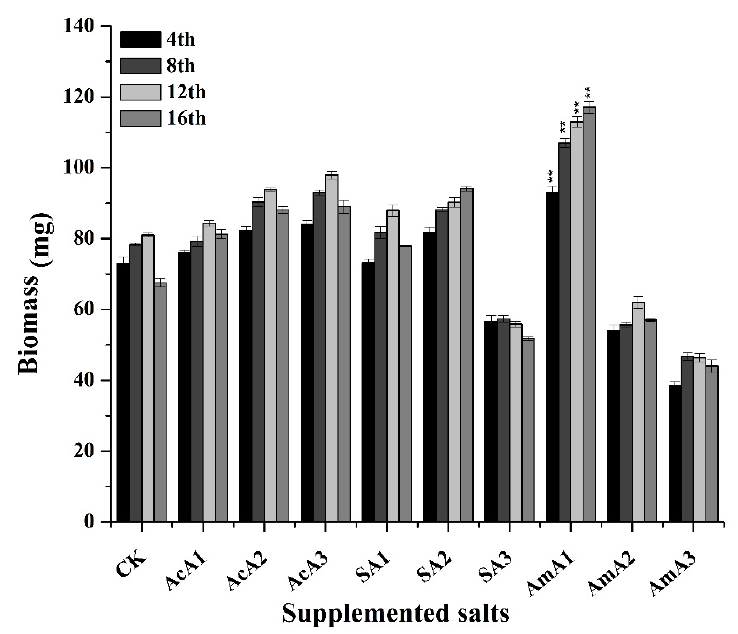
Figure 2. Biomass of M. ruber M7 grown on potato dextrose agar (PDA) spiked with acetic acid, sodium acetate, and ammonium acetate at different concentrations. Acetic acid: AcA1: 0.1%, AcA2: 0.25%, AcA3: 0.5%; Sodium acetate: SA1: 0.1%, SA2: 0.25%, SA3: 0.5%; Ammonium acetate: AmA1: 0.1%, AmA2: 0.25%, AmA3: 0.5%. CK: Control. Error bars show the standard deviation among the